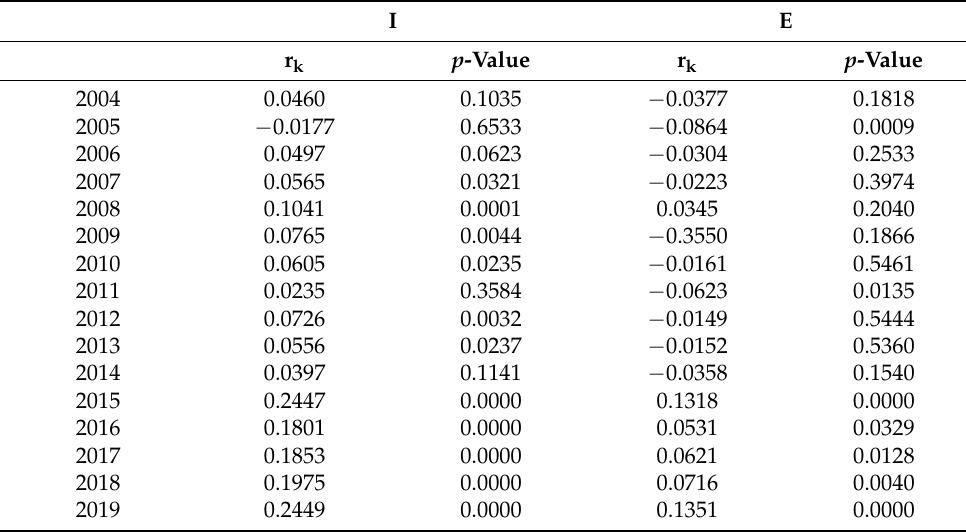
Table 4. Results of the correlation analysis of the relationship between the RCR index and in- come/expenditure in the years 2004–2019